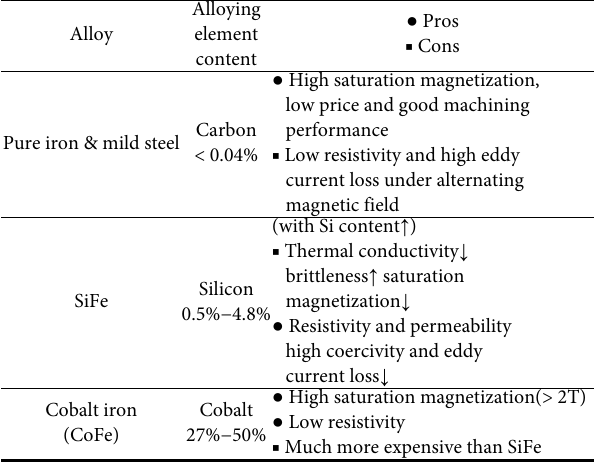
Table 2 Common soft magnetic materials and their